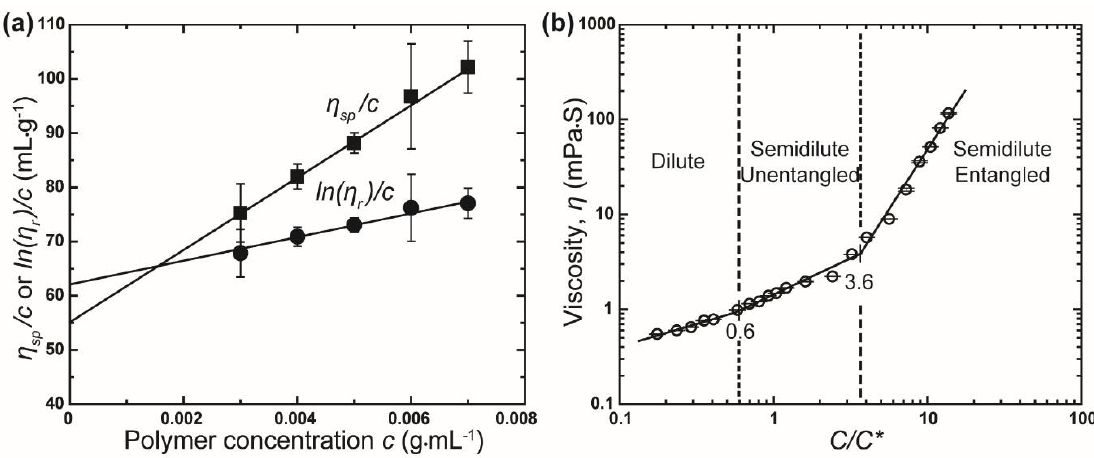
Figure 2. ( a ) Intrinsic viscosity of rPET solution obtained from Huggins and Kraemer equations and ( b ) scaling relationship between viscosity, η , and C/C* for various rPET solutions at 25 °C.